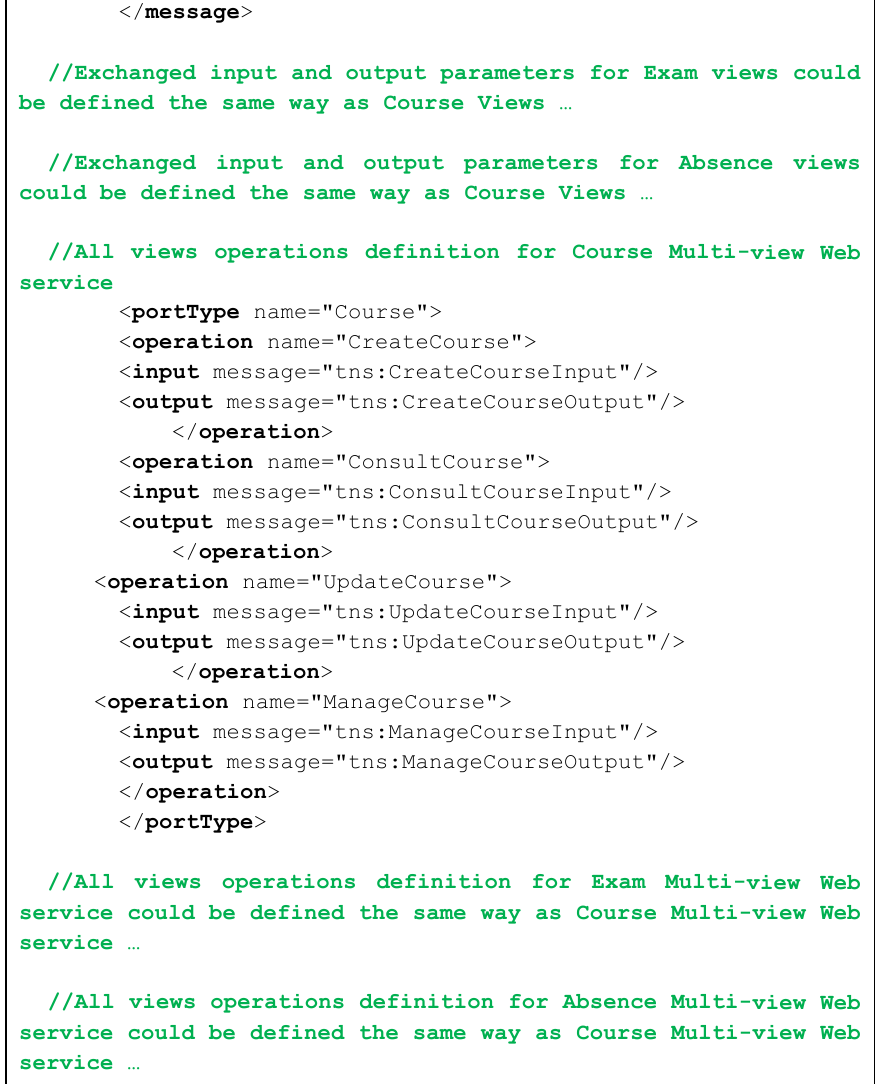
Fig. 5. The standard WSDL definition of Multi-view Web services automatically generated